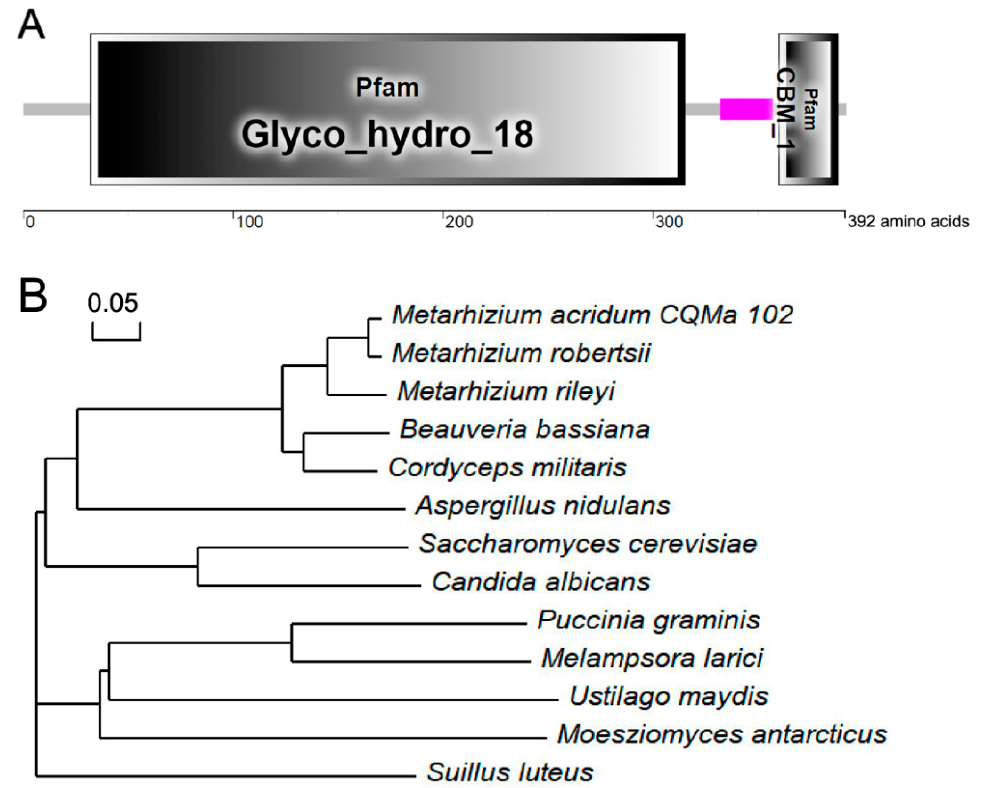
Figure 1. Structural and phylogenetic features of MaCts1 . ( A ) Domain structure analysis of MaCts1 . Glyco_hydro_18 is a glycosyl hydrolase family 18 domain and CBM_1 is a cellulose binding domain. ( B ) Phylogenetic analysis of Cts1 protein sequences from different fungi. The sequences used were Metarhizium acridum CQMa102, XP_007814832.1; Metarhizium robertsii , EXU99126.1; Metarhizium ri ‐